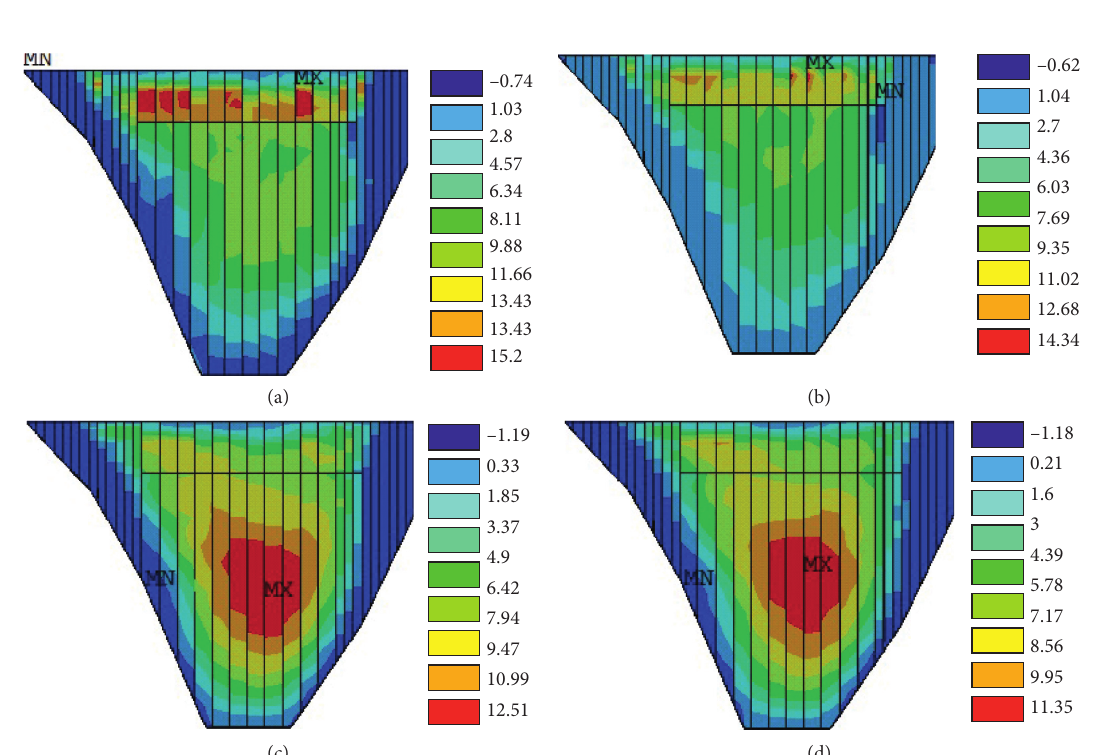
Figure 12: Stress distribution of concrete slab after earthquake. (a) The stress distribution of concrete slab in the along-slope direction based on UHS along-slope (UHS). (b) The stress distribution of concrete slab in the along-slope direction based on site-related response spectrum using scenario earthquake (SRRS) along-slope (SRRS). (c) The stress distribution of concrete slab in the axial direction based on UHS axial (UHS). (d) The stress distribution of concrete slab in the axial direction based on site-related response spectrum using scenario earthquake (SRRS) axial